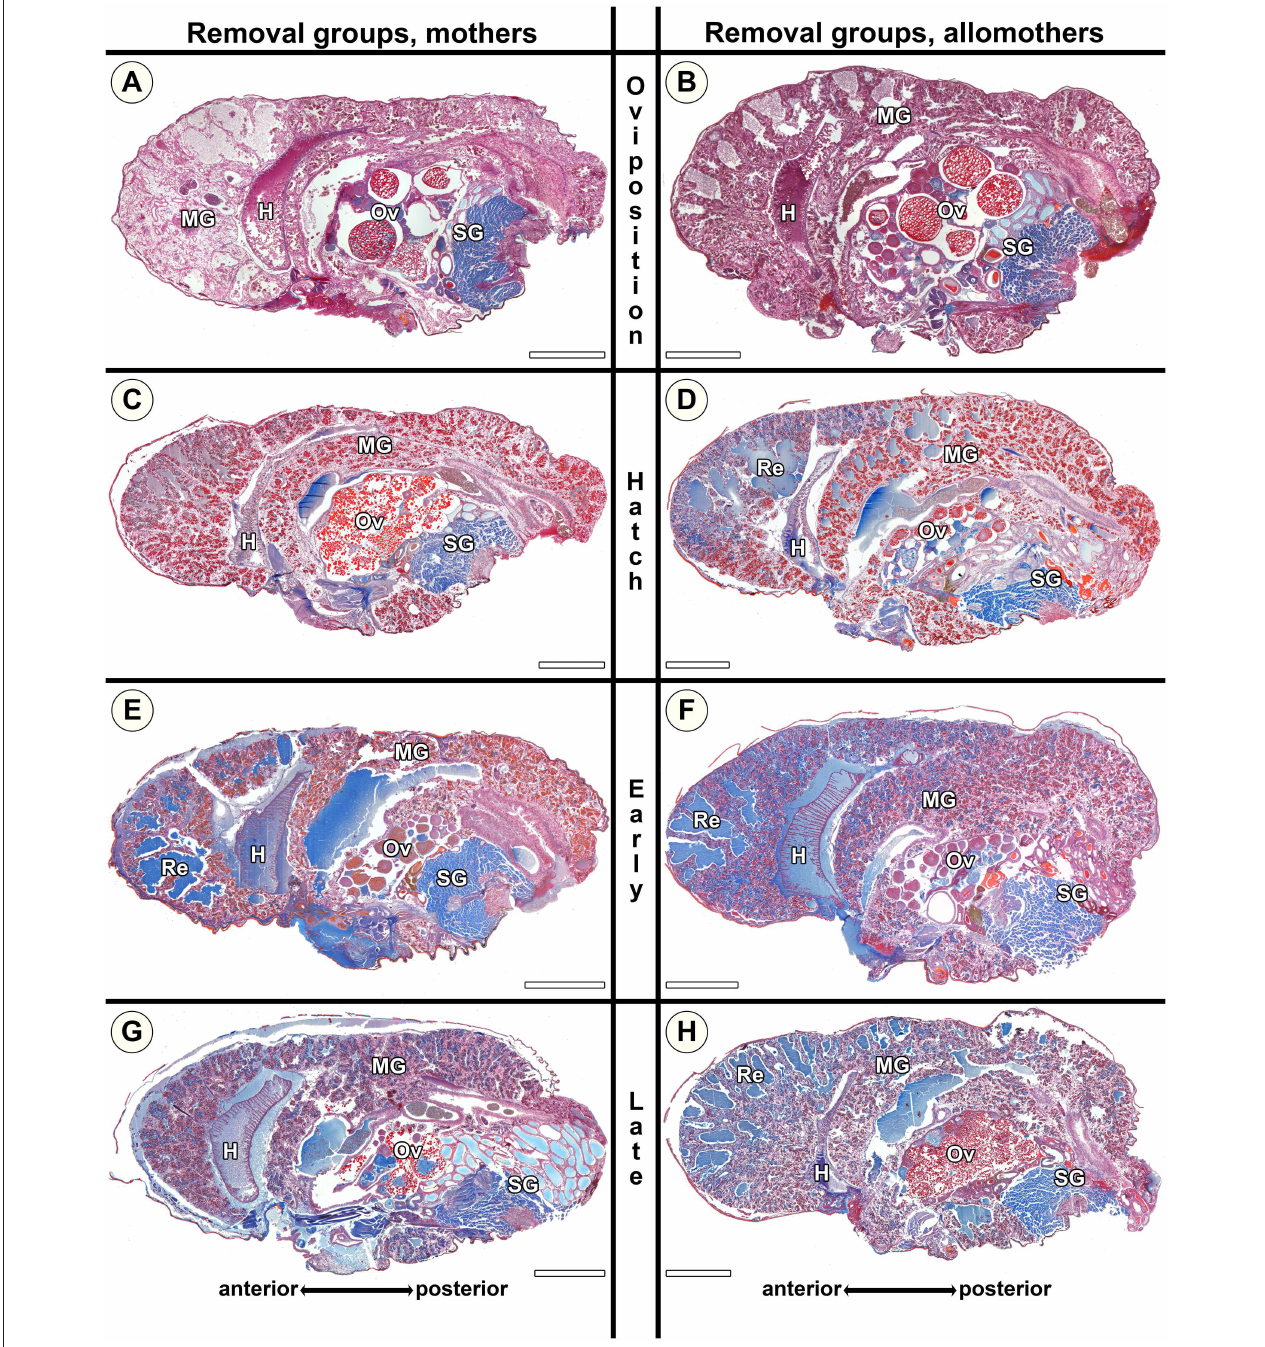
FIGURE 8 | Histological sections of opisthosomata of Stegodyphus dumicola mothers (left column) and allomothers (right column) of the removal group of which egg sacs or offspring had been removed. Offspring was removed at (A,B) oviposition (Ro); (C,D) hatching of spiderlings (Rh); (E,F) early regurgitation phase (Rer; 6 days after hatching); (G,H) late regurgitation phase (Rlr; 24 days after hatching). Females were chemically fixed 31 days after hatching at the time matriphagy would occur under natural conditions. Mothers and allomothers show almost no blue stained secretion granules when offspring were removed at time of hatching (C,D) compared to females of the same stage in the natural group. Extracellular material (regurgitant) is accumulating more in mothers from early regurgitation and in allomothers from hatching onwards than in control groups, suggesting the inability to terminate and reverse production of material for regurgitation feeding when offspring were removed at hatching. Ovaries of mothers and allomothers frequently show late-vitellogenic oocytes (A–C,G,H) . H, heart; MG, midgut; Ov, ovary; Re, extracellular material (regurgitant); SG, silk gland. All scale bars are 2,000 µ m.